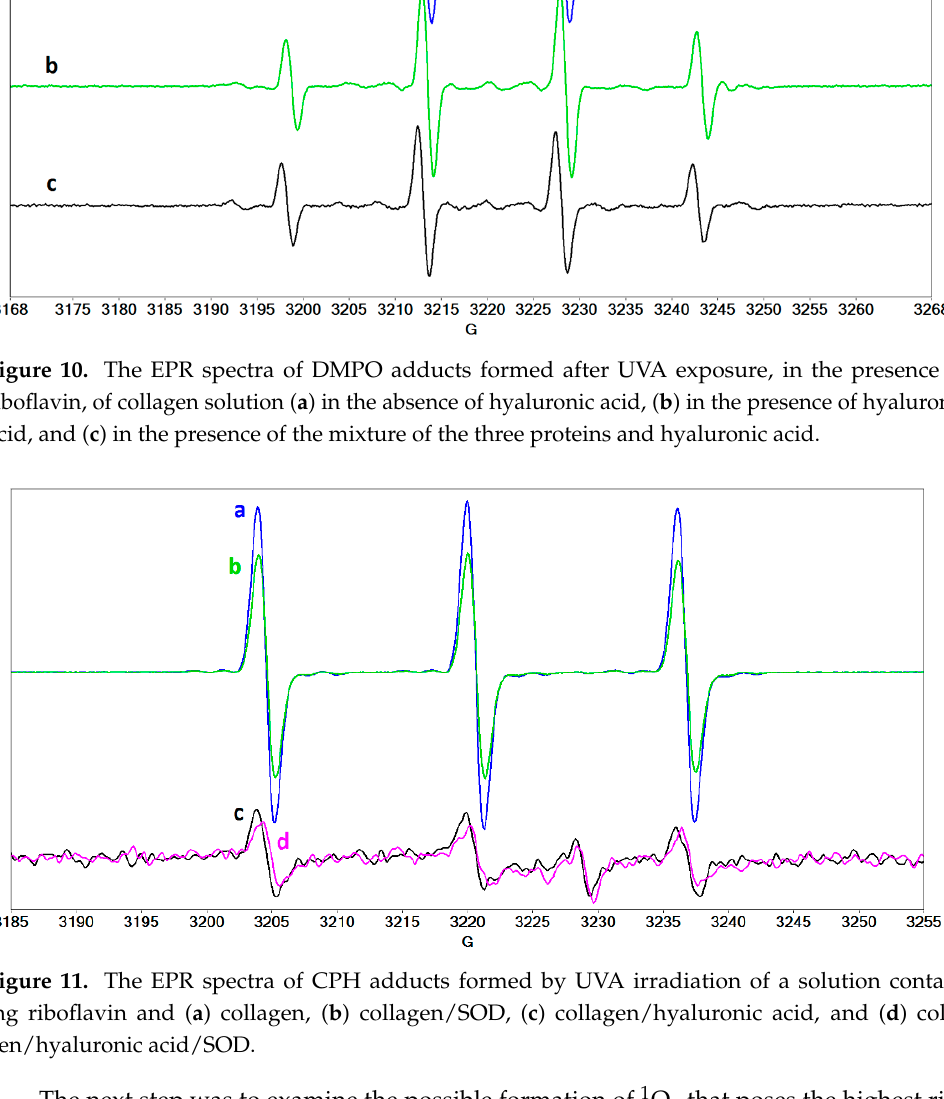
Figure 11. The EPR spectra of CPH adducts formed by UVA irradiation of a solution containing riboflavin and ( a ) collagen, ( b ) collagen/SOD, ( c ) collagen/hyaluronic acid, and ( d ) colla- gen/hyaluronic acid/SOD.